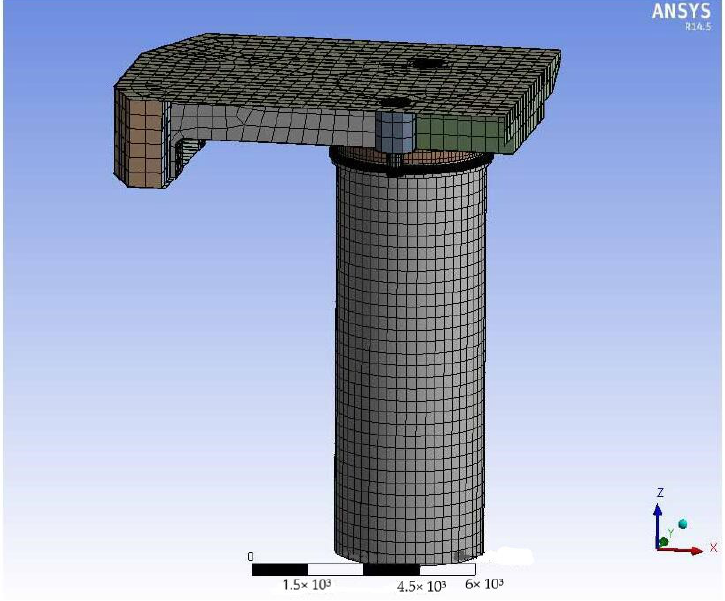
Figure 8. Assembly body meshing results.